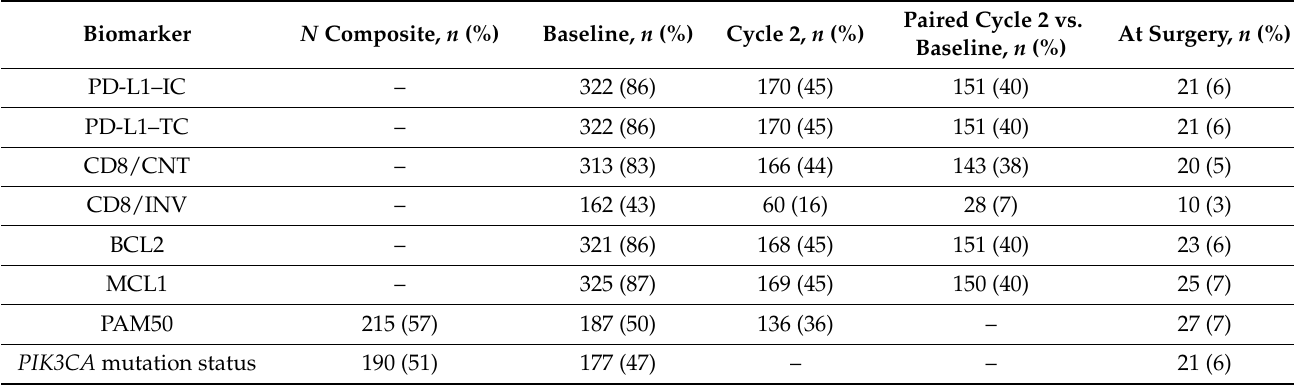
Table 1. Availability of